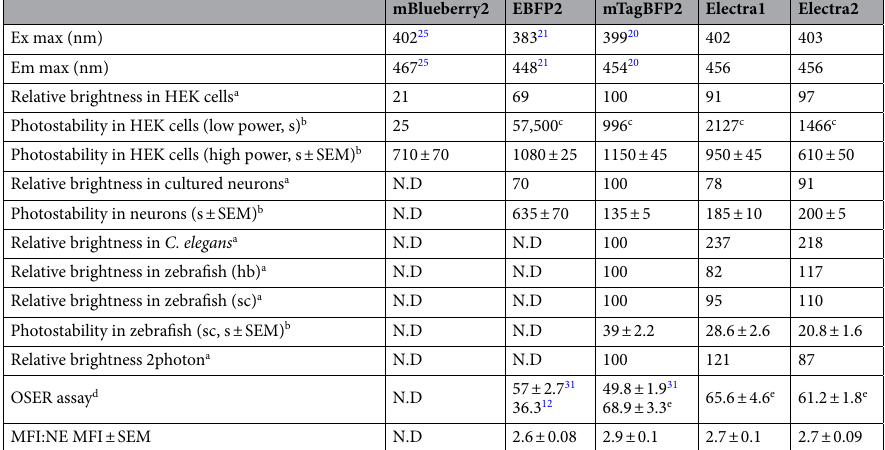
Table 1. Spectral characteristics and performance of the selected BFPs. a Refers to mean intracellular brightness ratio normalized to mTagBFP2; b Refers to mean fluorescence half-time; c Estimated using linear fit extrapolation; d Fraction of cells with normal ER reported as % of cells ± SEM; e Values reported in this